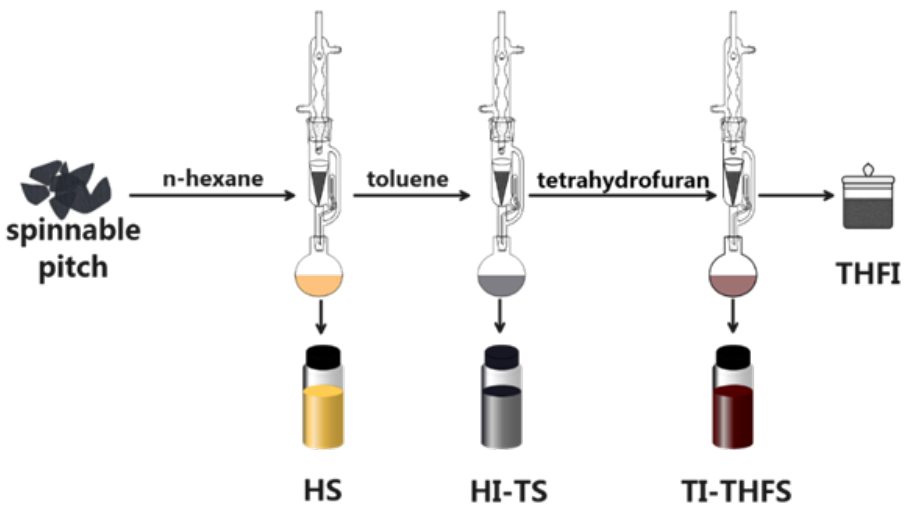
Scheme 1. Separation procedure of spinnable pitch by soxhlet extraction.